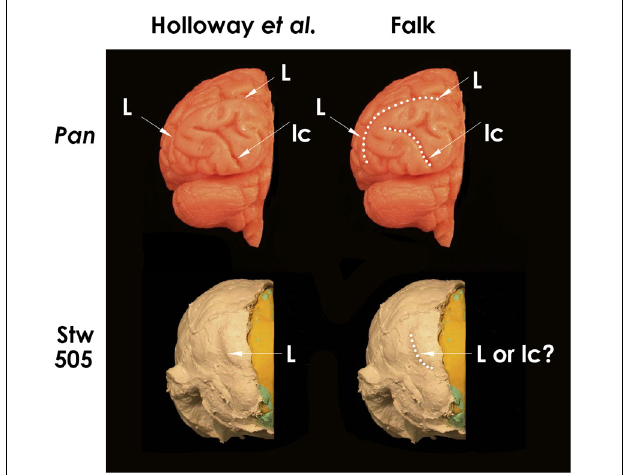
FIGURE 2 | Posterior views of left hemispheres of a chimpanzee brain cast (above) and the Stw 505 Australopithecus africanus partially reconstructed endocast (below), with the midsagittal planes identified by Holloway et al. (2004b: Figure 3) approximately aligned. Sulci indicated on the left are dotted in for clarity on the right. The identifications on the left are Holloway et al.’s; those on the right are the author’s. Abbreviations: L , lunate sulcus; lc , lateral calcarine sulcus. As indicated on the right, the author confirms Holloway et al.’s sulcal identifications for the chimpanzee brain, but thinks that the sulcus they identified as L on Stw 505 looks more like the medial part of lc in the chimpanzee brain. Figure after Holloway et al. (2004b), Copyright © 2004, Académie des sciences. Published by Elsevier Masson SAS. All rights